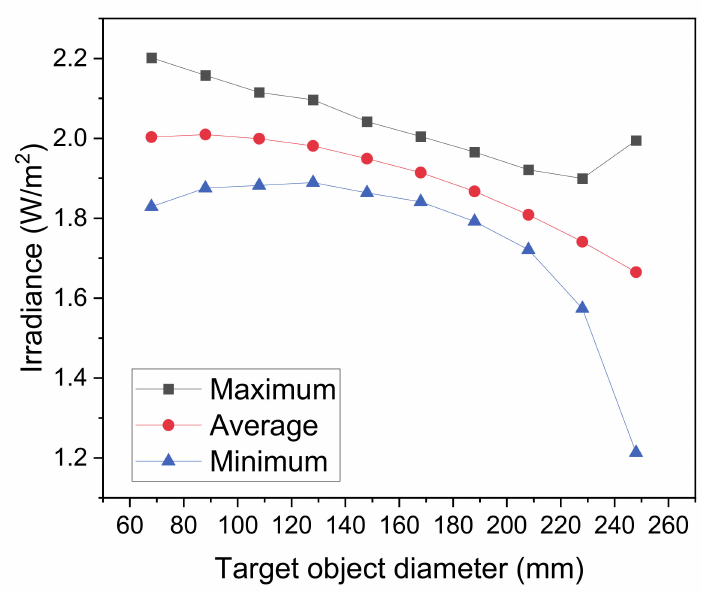
Figure 8. Irradiance as a function of the internal object